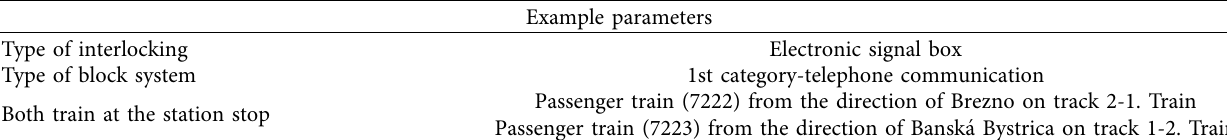
Table 8: Input data necessary for the calculation of the interval of crossing.